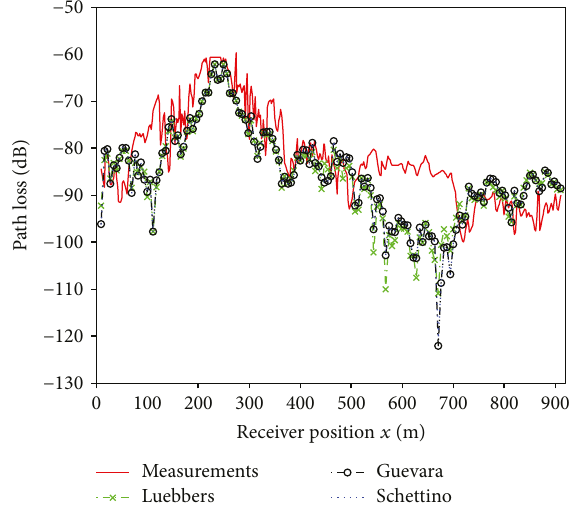
Figure 17: Path loss comparison of model and measured data (red line) for Slater